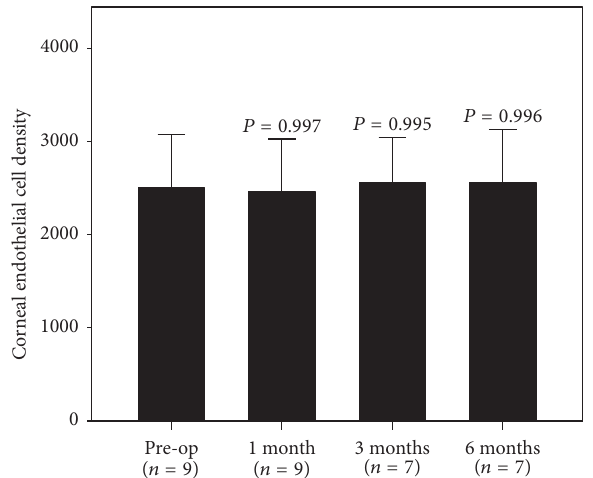
Figure 2: Mean corneal endothelial density (+ standard deviation) ateachstudyvisit.Nostatisticallysignificantchangefromthepreop- erative corneal endothelial density was noted (Dunnett’s procedure versus